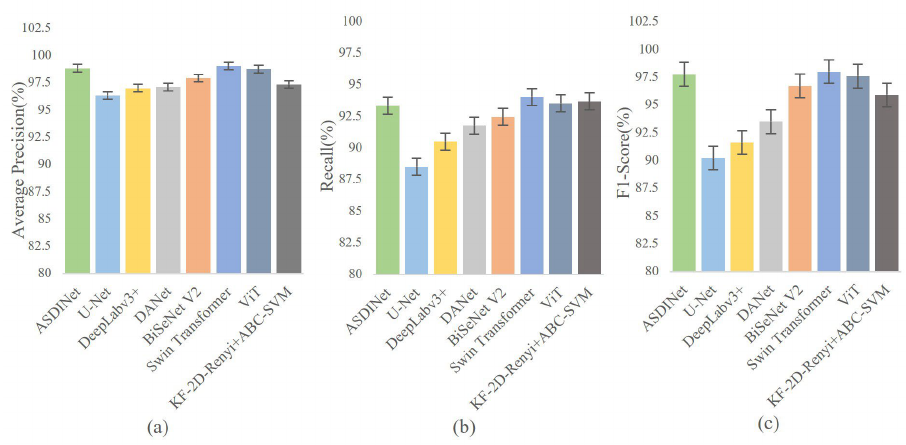
Figure 7. Comparison with state-of-the-art networks. Among them, ( a ) represents the AP of each model, ( b ) represents the Recall of each model, and ( c ) represents the F1-score of each model.